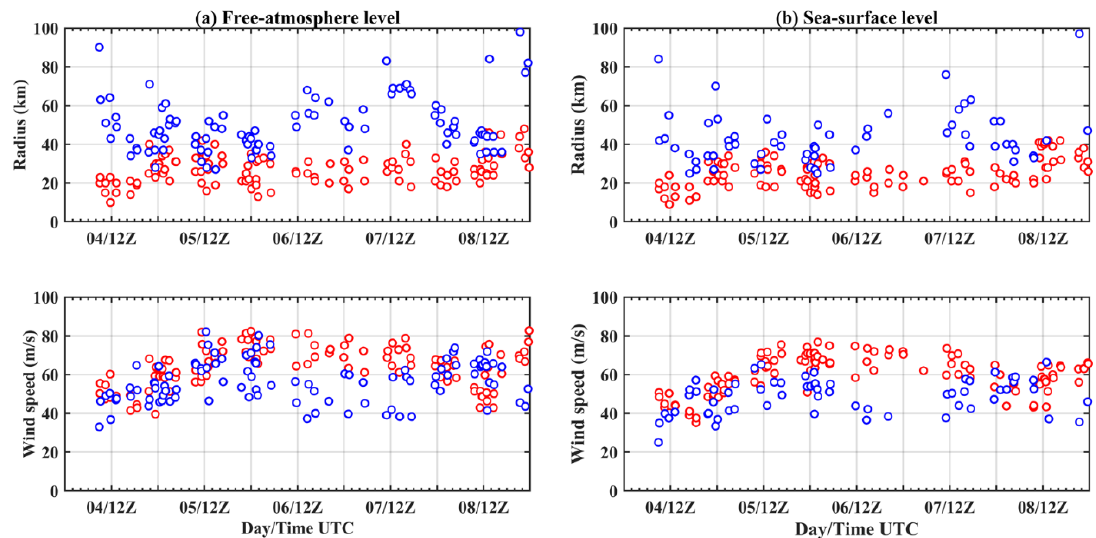
Figure 5. The evolution of wind profile parameters in Hurricane Irma (2017) at the ( a ) free-atmosphere level and ( b ) sea-surface level. The top panel in each subfigure denotes the evolution of radii parameters 𝑟 1 (red circles) and 𝑟 2 (blue circles). The bottom panel in each subfigure denotes the evolution of intensity parameters 𝑣 1 (red circles) and 𝑣 2 (blue circles).